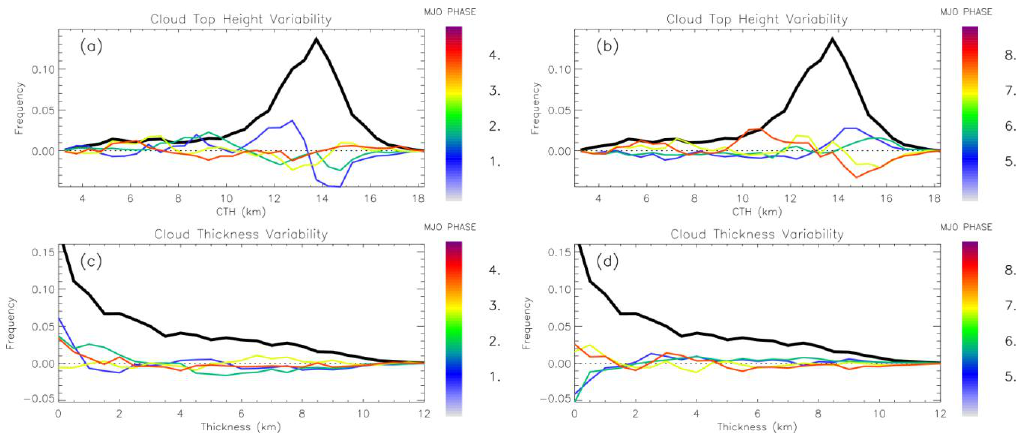
Figure 18: Same as Fig. 3 but for the MJO Phases: upper panel for Phases 1 to 4, lower panel for phases 5 to 8